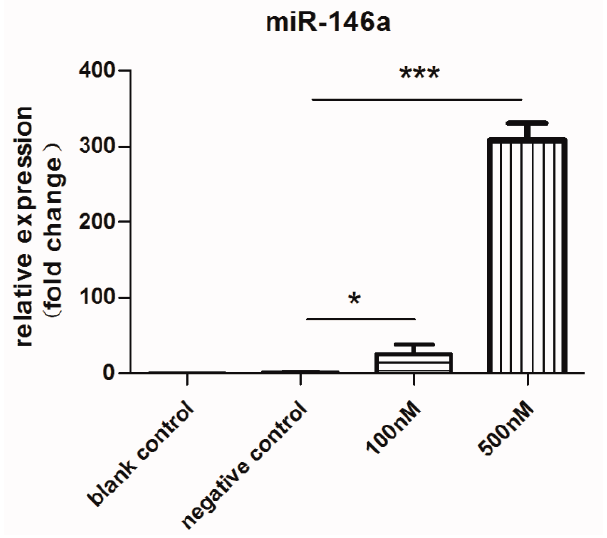
Figure 1. qRT-PCR analysis of miR-146a after 3 days of incubation with MS2 virus-like particles (MS2 VLPs). Cells were stimulated with RANKL/M-CSF for 3 days and treated with 100 or 500 nM MS2-miR-146a VLPs (test groups) or 500 nM MS2-miRNC VLPs (negative control group). Total RNA was extracted from harvested cells using Trizol and stem-loop RT primers were used for reverse transcription. Subsequently, real-time PCR was performed with U6 as an internal reference. The relative expression levels of miRNAs were calculated by the 2 −ΔΔ C t method. * p < 0.05, *** p < 0.001. Each experiment